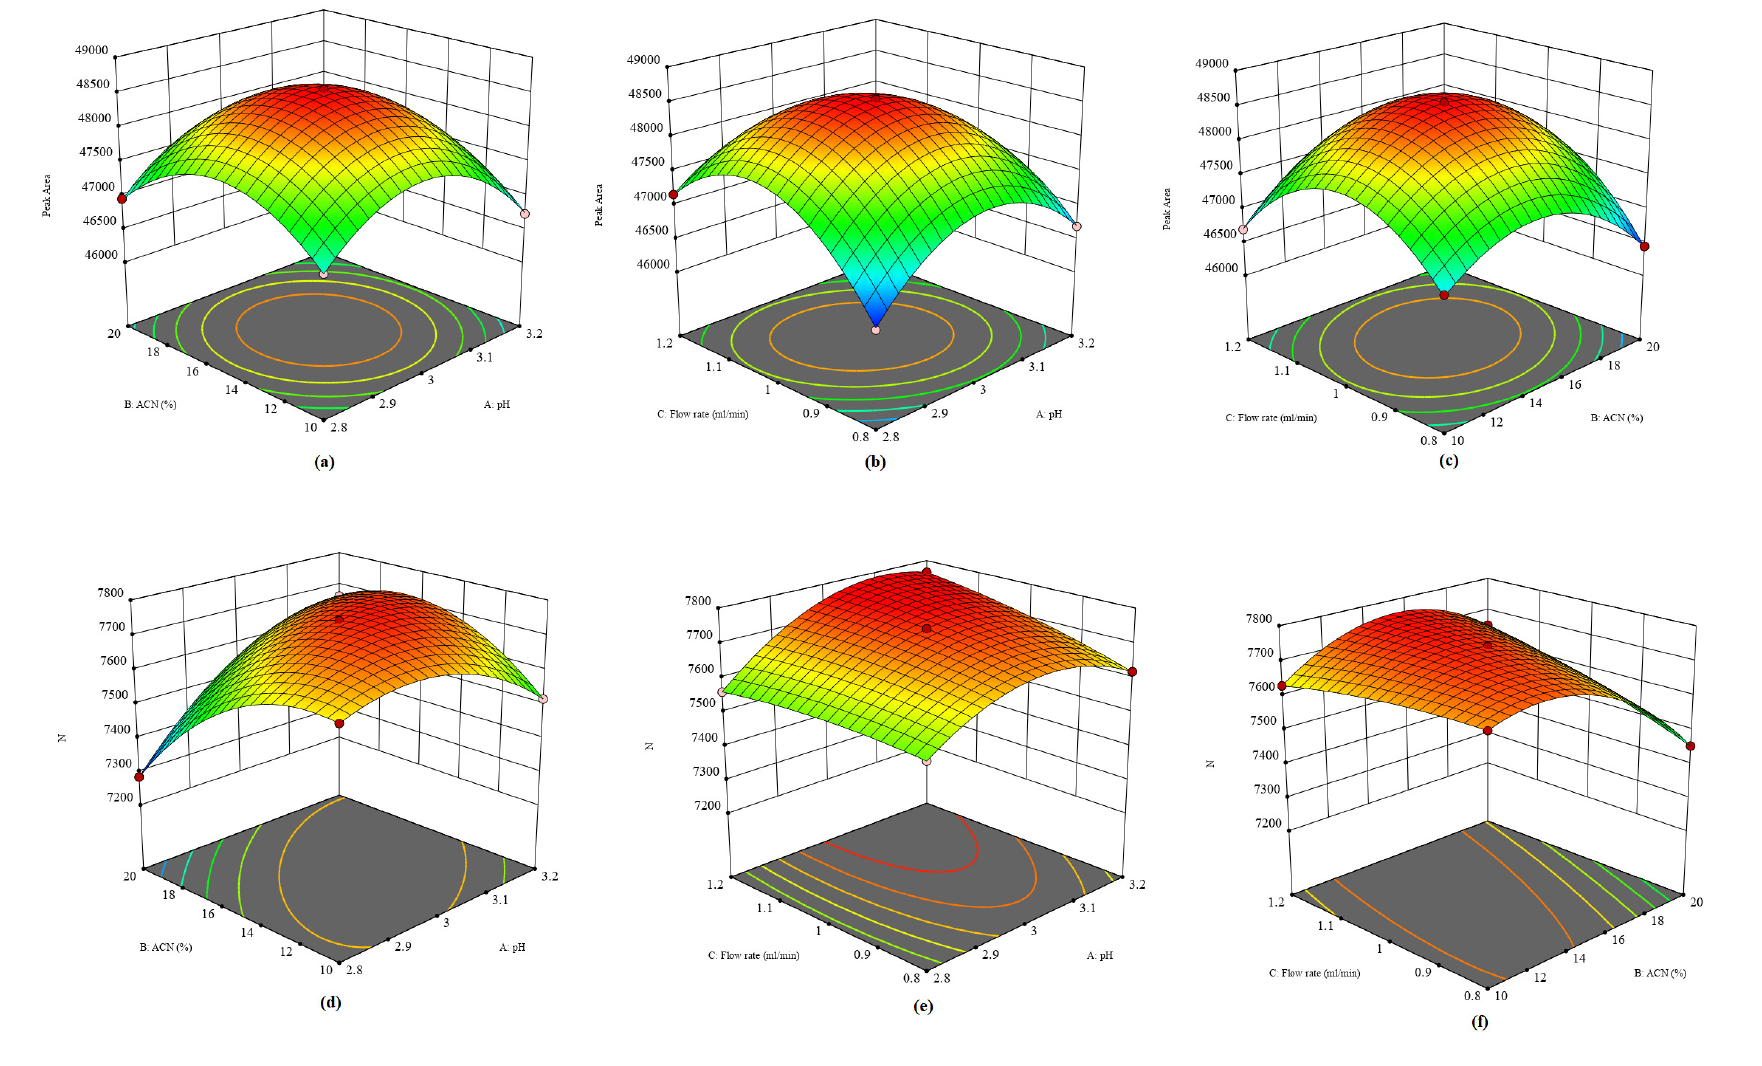
Figure 3. 3D surface plot with peak area signifying the relations between (a) pH and ACN (b) pH and flow rate (c) ACN and flow rate; with theoretical plate (d) pH and ACN (e) pH and flow rate (f) ACN and flow rate and their influences on the responses to determine acetic acid